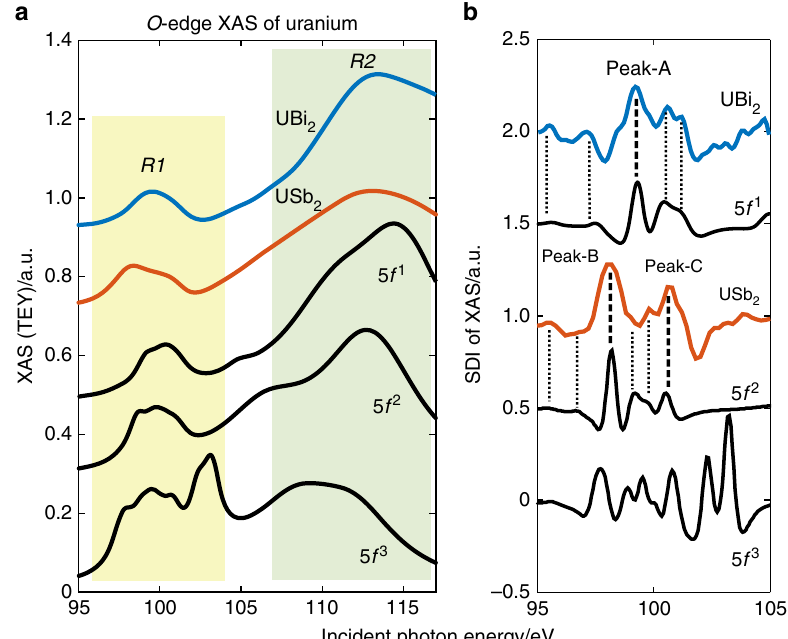
Fig. 2 XAS fi ne structure and valence of UBi 2 and USb 2 . a The x-ray absorption of UBi 2 and USb 2 on the O-edge of uranium is compared with (bottom) multiplets simulations for 5 f 1 (U 5 + ), 5 f 2 (U 4 + ), and 5 f 3 (U 3 + ). b A negative second derivative (SDI) of the XAS data and simulated curves, with drop- lines showing feature correspondence. Noise in the SDI has an amplitude comparable to the plotted line thickness, and all features identi fi ed with drop-lines were consistently reproducible when moving the beam spot. Prominent absorption features are labeled peak-A (UBi 2 , h υ = 99.2 eV), peak-B (USb 2 , h υ = 98.2 eV), and peak-C (USb 2 , h υ = 100.8 eV). Source data are provided as a Source Data fi le